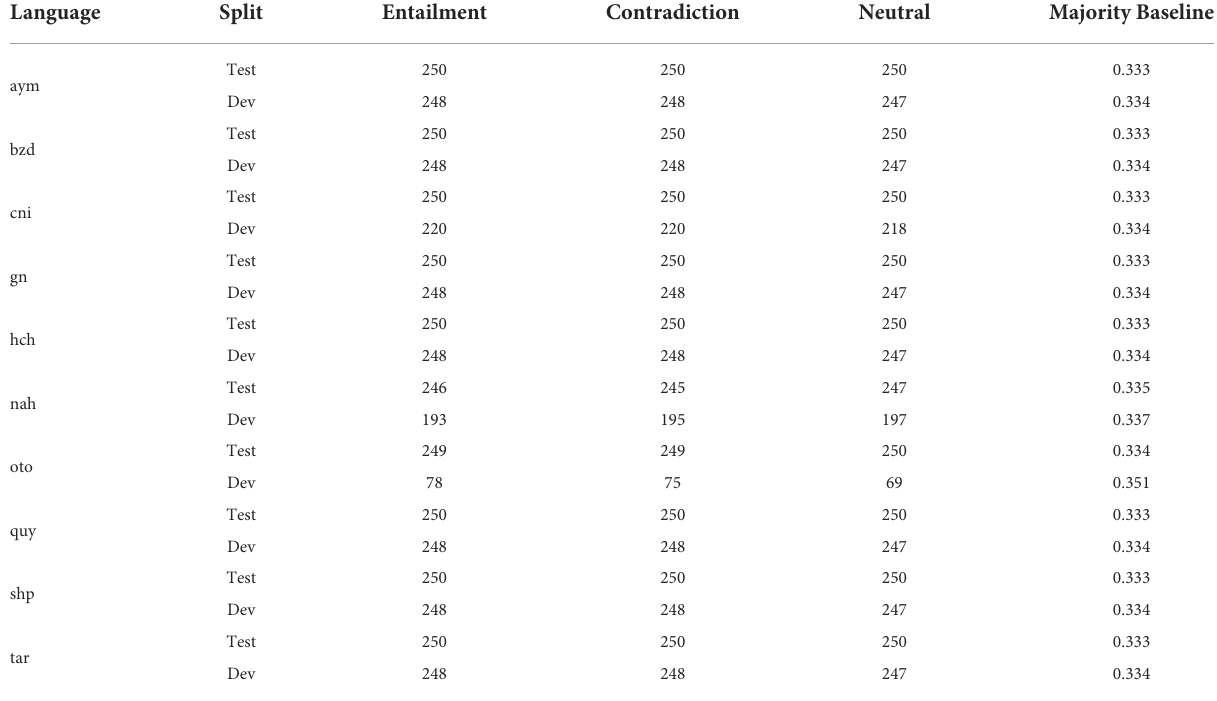
TABLE 3 Distribution of labels in the test and development sets, per language. Language Split Entailment Contradiction